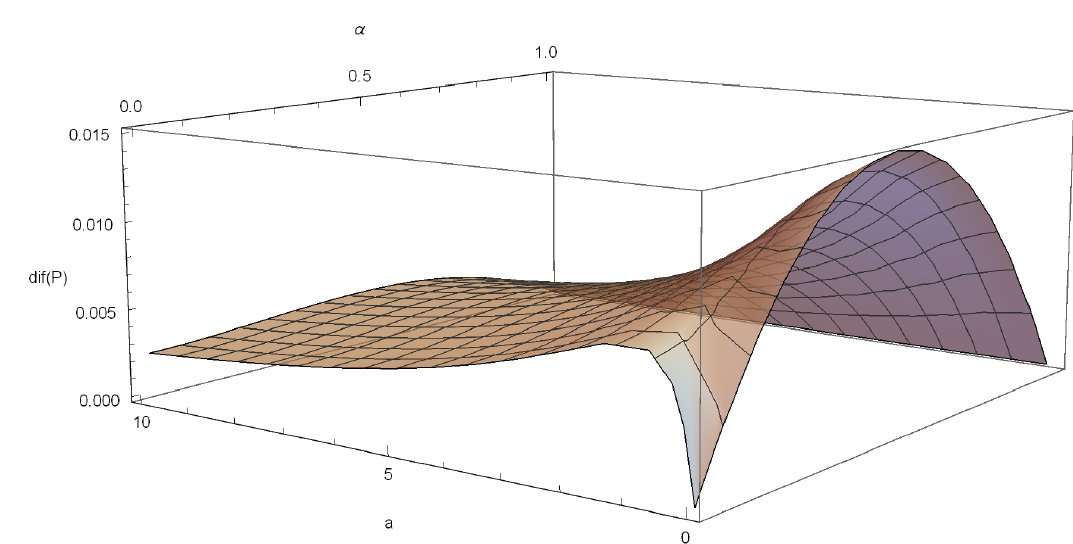
Fig 7. dif ( P ) in the Poisson-Pareto case with δ = 0.03, λ = 1, θ = 0.6.